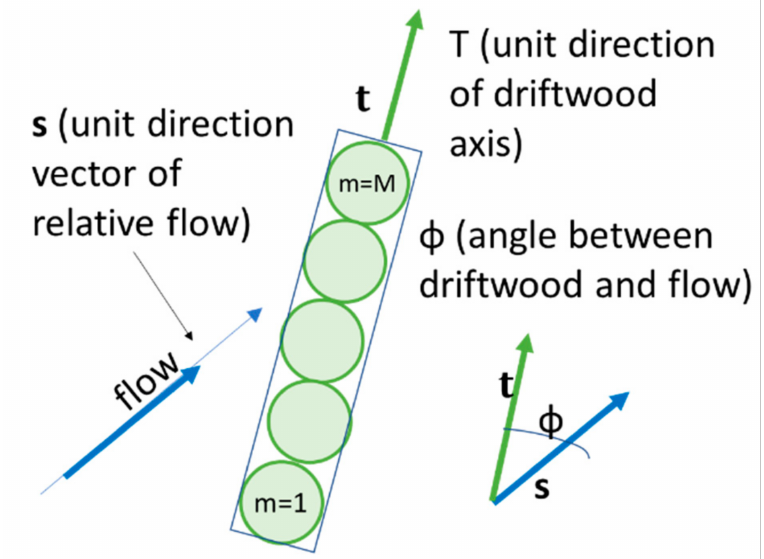
Figure 3. Relationship between flow direction and driftwood axis direction.